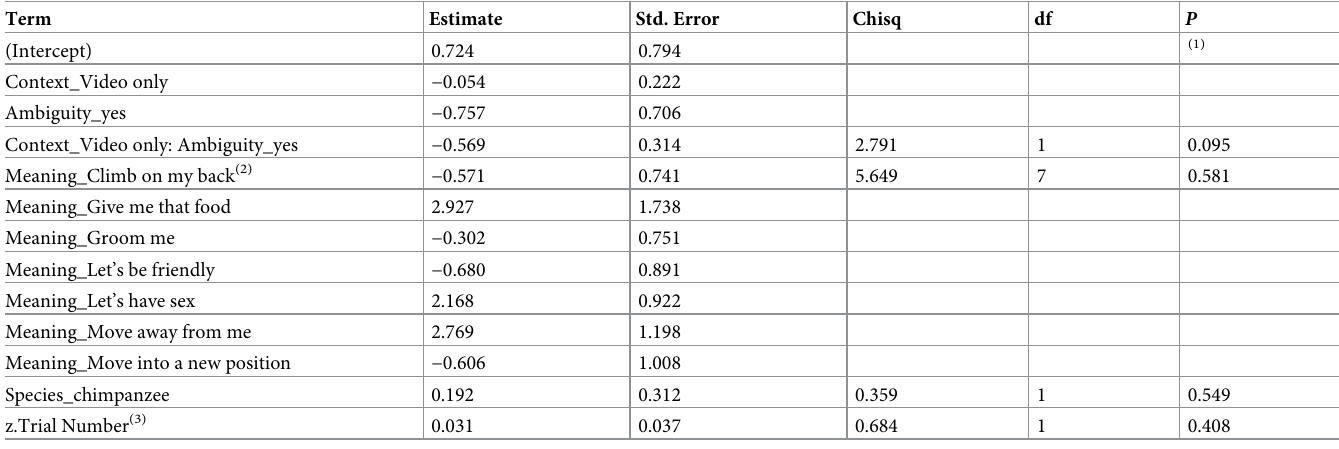
Table 1. Results of the glmm (estimates, standard errors, and significance